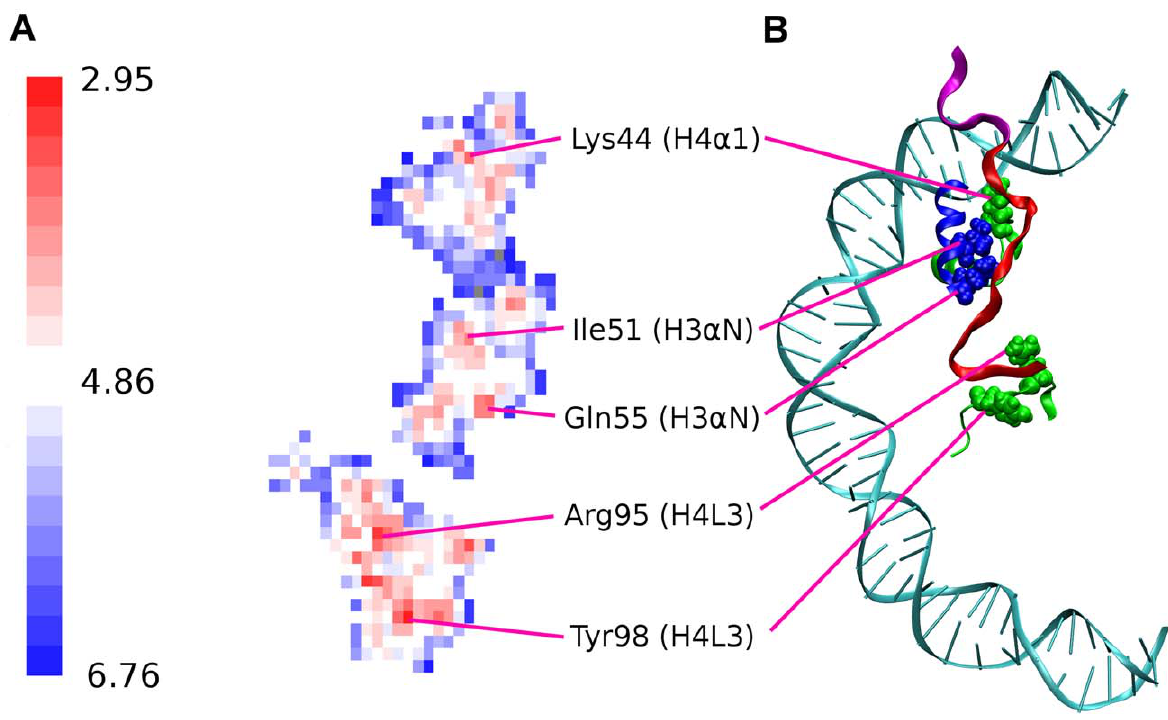
Figure 11. Interaction of H2A C terminal extension (amino acids 100–129) with surrounding residues. (A) Molsurfer [47] generated contact map of H2A C terminal docking domain (amino acids 100–119) interaction surface as derived from interatomic distances calculated from the structure averaged over the 100 ns of the intact nucleosome trajectory. Distances (in units of A˚) are color coded as shown in the scale. Residues in close contact with H2A C terminus are indicated. (B) Positions of the H2A C terminal docking domain (colored red) close contact residues are shown in the nucleosome structure. The end of the H2A C terminus (amino acids 120–129) is colored magenta.